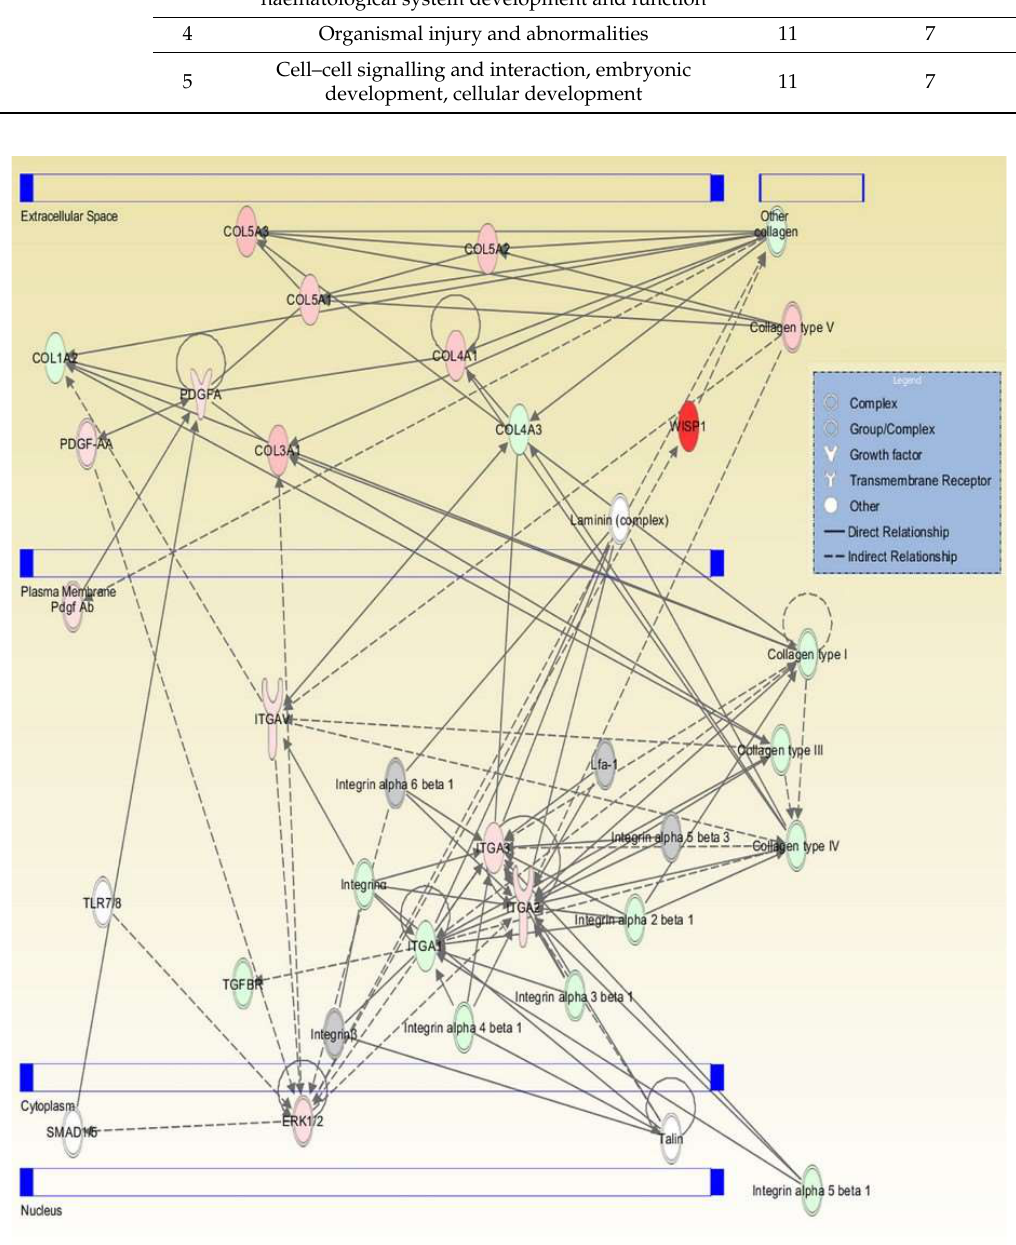
Figure 5. Graphic represents the interaction relationships for DFCM-KM. The mutual genes in the target network are displayed as nodes, and include collagen (ECM), PDGF (platelet-derived growth factor) (growth factor) and integrin (cell adhesion molecules), which activate the ERK/MAPK (extracellular signal–regulated kinase/mitogen-activated protein kinase) pathway. Red nodes indicate upregulated genes; green nodes indicate downregulated genes.